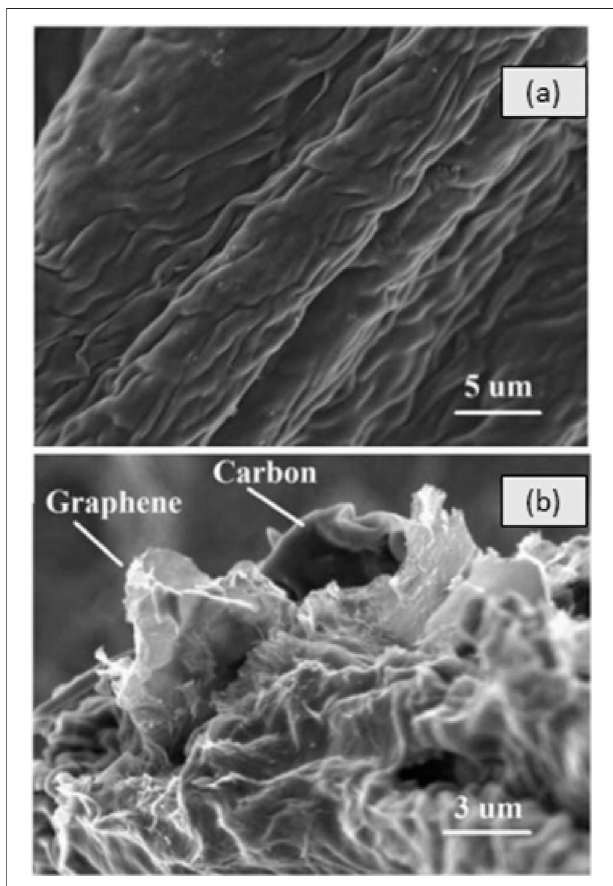
FIGURE 5 | SEM images of (A) activated carbon (AC) and (B) activated carbon graphene (ACG) (Yarmand et al., 2016).